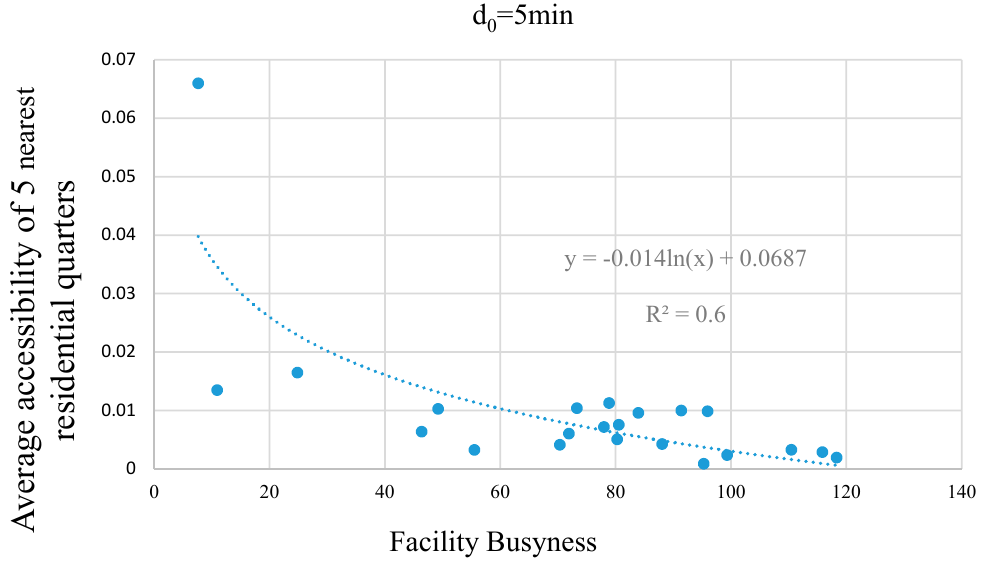
Figure 8. Fire facility busyness versus averaged residential quarter accessibility across the whole study area (based on 5-min travel time).